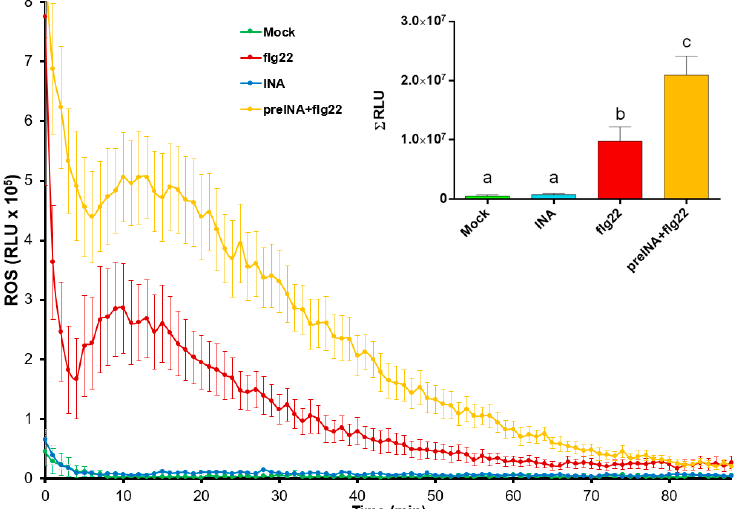
Figure 2. Reactive oxygen species (ROS) production in bean leaf-disks subjected to different treat- ments: water (Mock, green line), 100 μ M INA (INA, blue line), 1 μ M flg22 (flg22, red line), or 1 μ M flg22 after pre-treatment with 100 μ M of INA (preINA + flg22, yellow line), and measured as relative light units (RLU) produced by Luminol reaction over the time. Total areas under the curves were integrated, and resultant values are represented at the right side of the panel. Data represent mean ± SE ( n = 8) from one experiment representative of three independent ones with similar results. Statistically significant differences, indicated by letters, were achieved according to one-way ANOVA ( p < 0.05), by post hoc Tukey test.